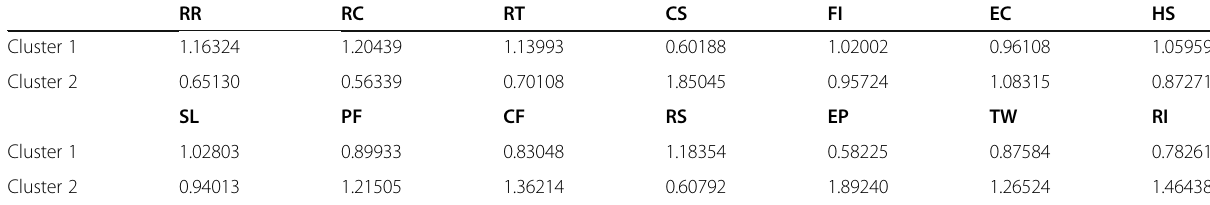
Table 3 Enrichment factors of POI in clusters